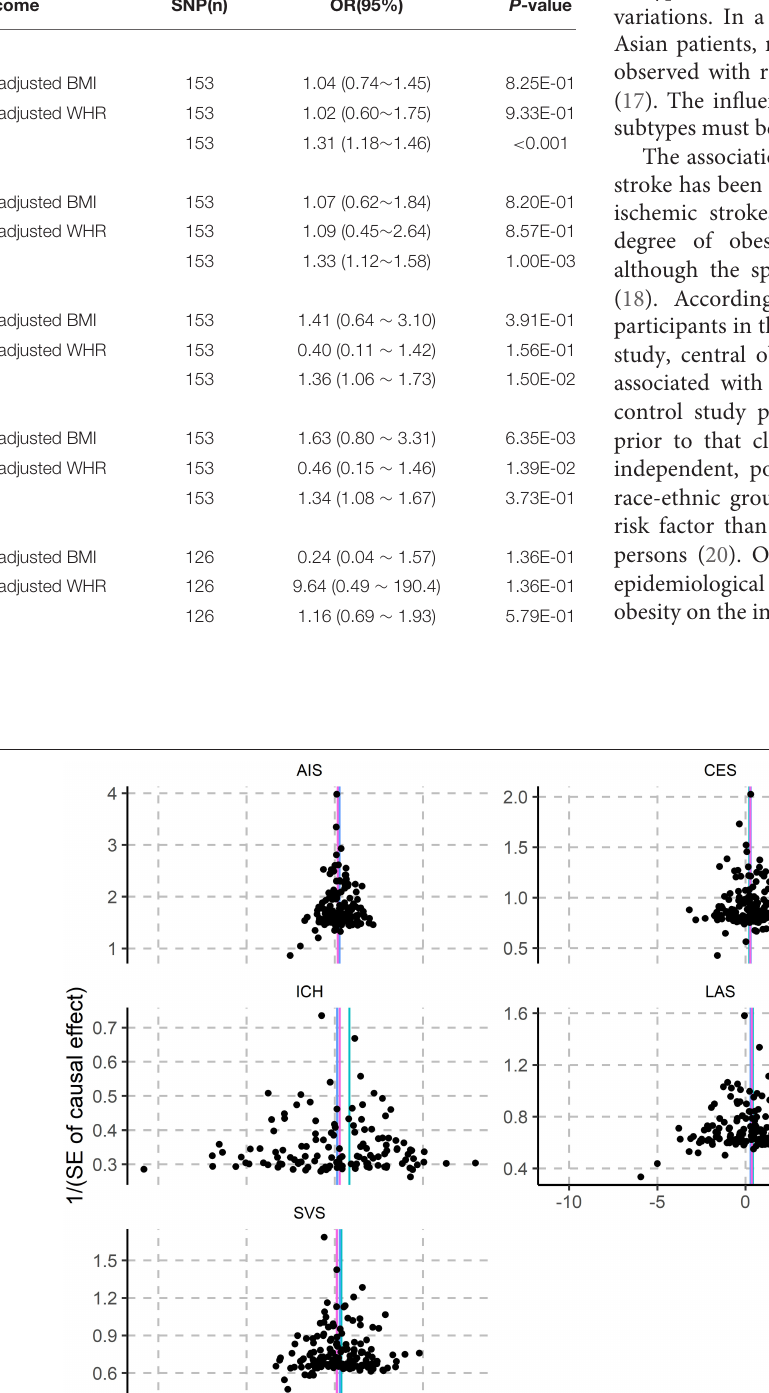
Frontiers in Neurology |